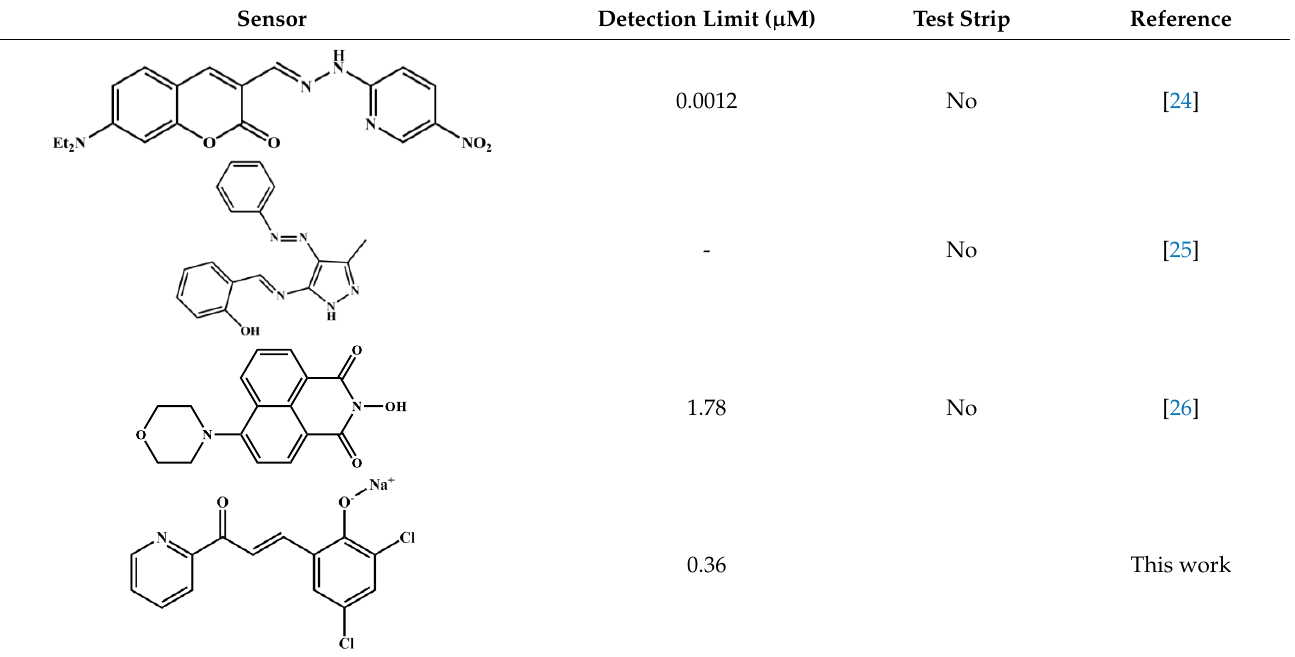
Figure 3. Job plot for DPP with Ni 2+ at 550 nm.